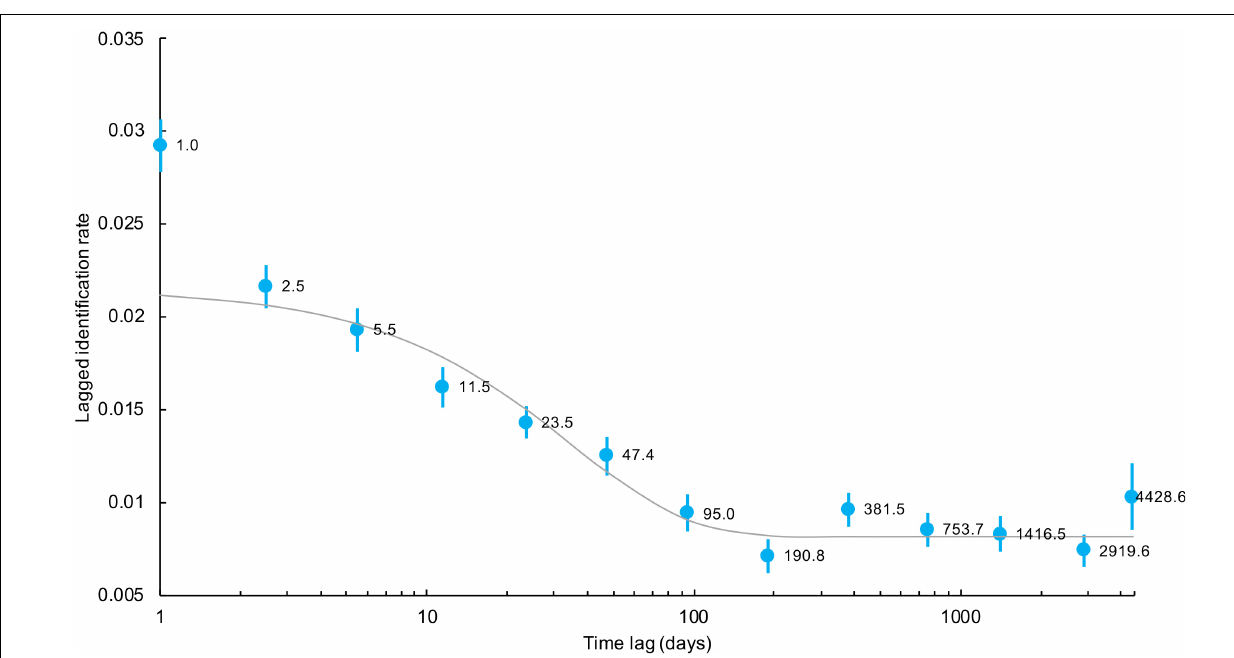
FIGURE 10 | Lagged identification rates (blue circles), standard errors (bars), and the expected lagged identification rate (line) from the most parsimonious maximum likelihood model incorporating emigration and re-immigration for M. alfredi in Coral Bay, Western Australia. Numbers beside lagged identification rates represent the mean time lag in days for each estimated point.